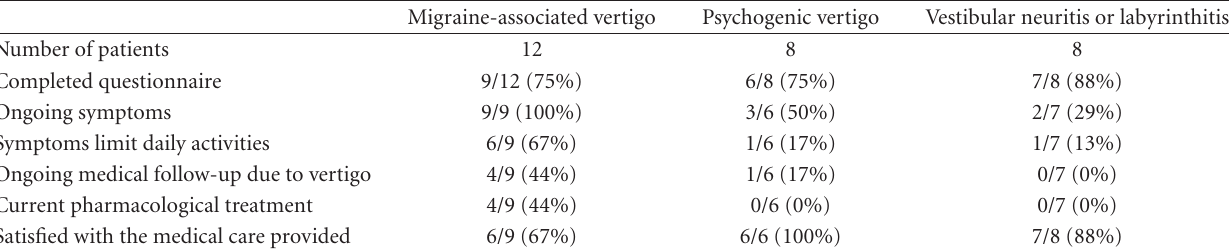
Table 2: Follow-up outcome of the three major etiology